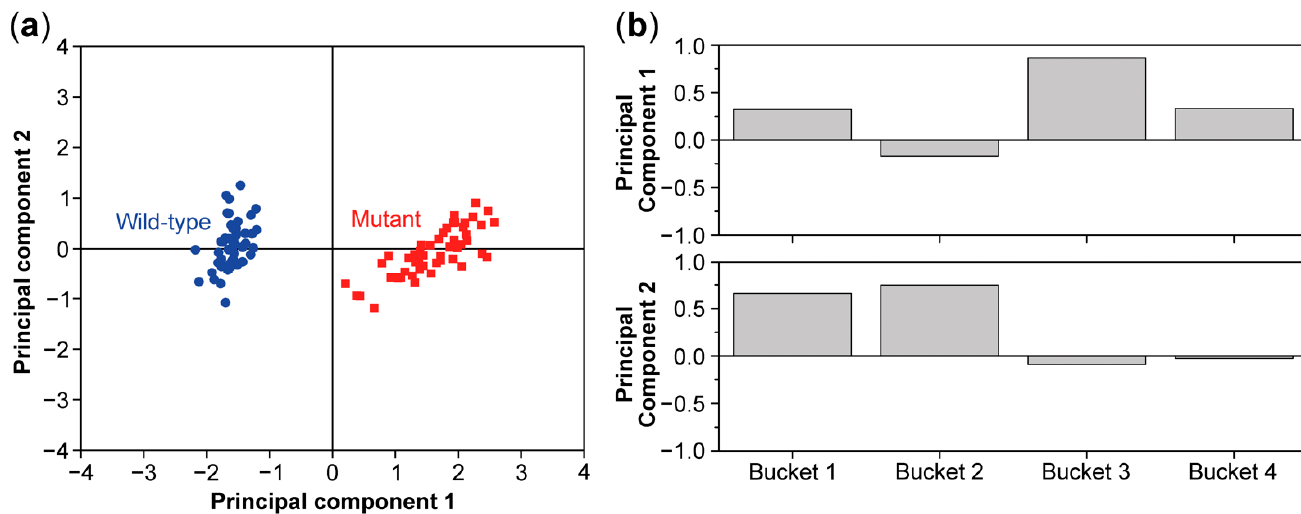
Figure 7. PCA score ( a ) and loading plot ( b ) of a data set including 50 wild-type samples and 50 mutant samples and 4 buckets for every sample. The score plot shows a clear separation between the wild type and mutant. The PCA loading plot shows that bucket 3 has the most influence on the first principal component and buckets 1 and 2 have the most influence on the second principal component.